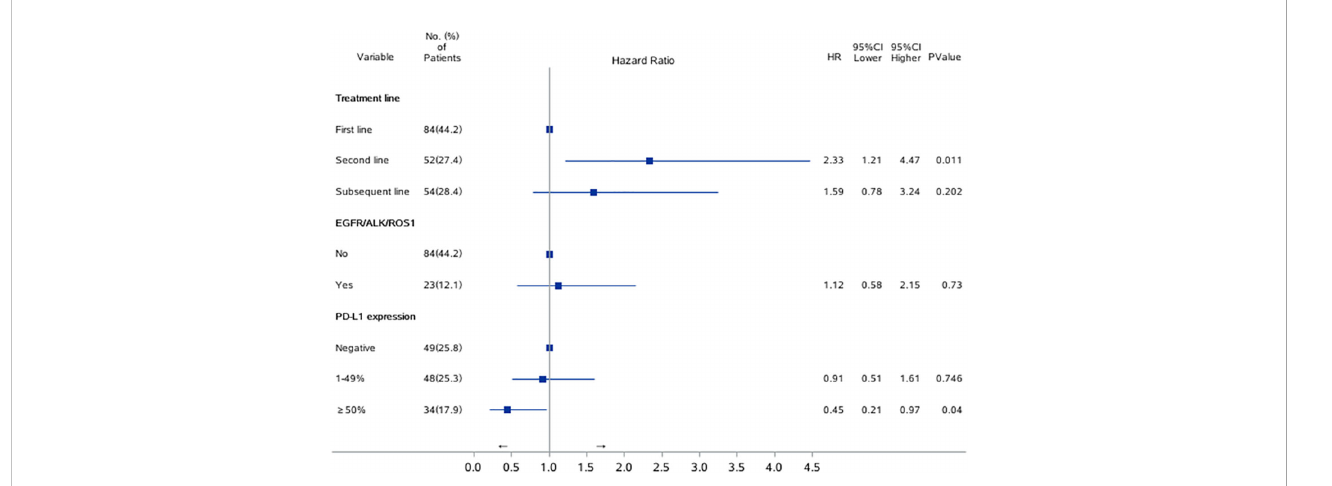
(Figure 12A). One hundred was set as the maximum score of each variable; by adding up the total score and locating it on the bottom point scale, an estimated probability of survival could be easily determined. Calibration plot of the nomogram is displayed in Figure 12B. The C-index of the built nomogram to predict PFS (0.74; 95% CI, 0.65 – 0.82) demonstrated an optimal consistency between the nomogram prediction and the actual observation for lung cancer patients treated with ICI. The ROC curve indicated that the nomogram model has a good predictive ability in predicting the clinical outcomes of lung cancer patients receiving ICI treatment (AUC: 0.777 for 1 ‐ year PFS) (Figure 12C).